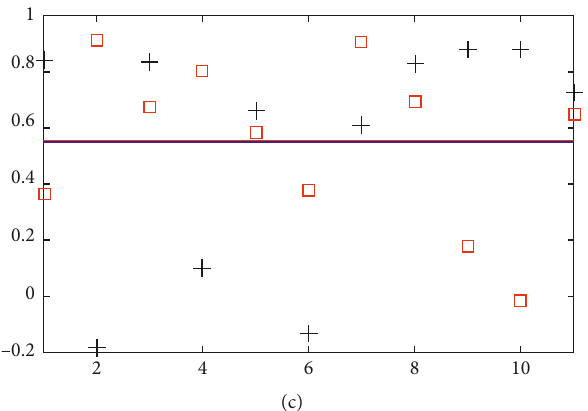
Figure 13: Distribution of DSF values depending on the AR process order: (a) version order of AR � 4, order of MA � 3; (b) version order of AR � 5, order of MA � 3; (c) version order of AR � 6, order of MA � 3.